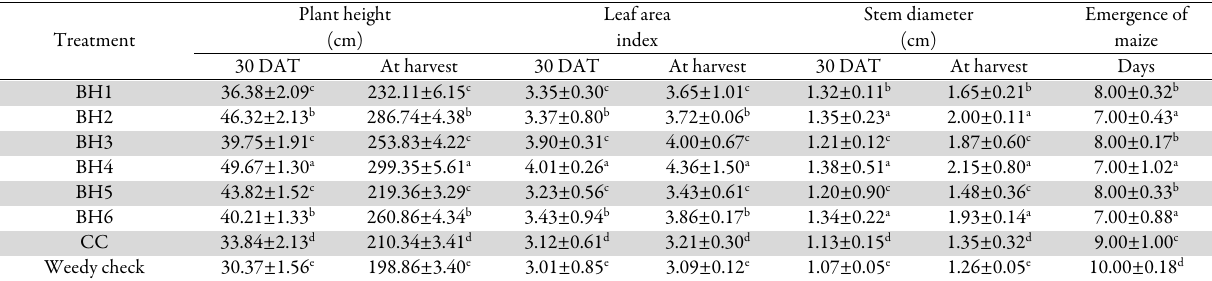
Table 2. The growth components of maize plant after application of various treatments